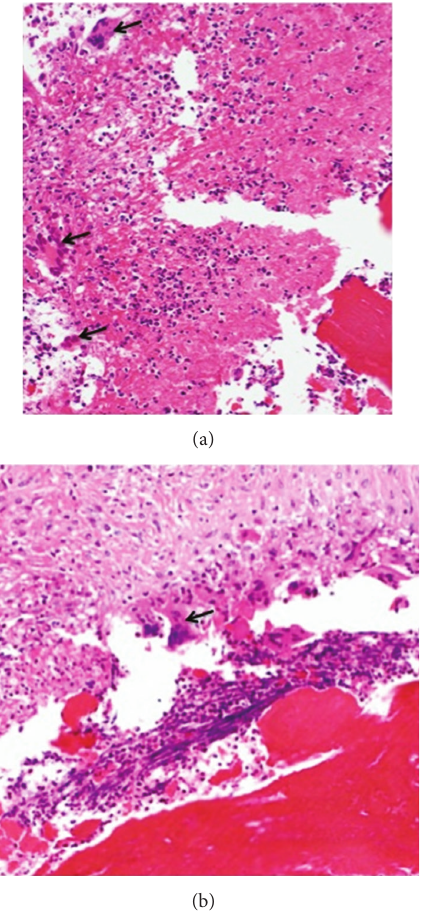
Figure 2: Multinuclear giant cells. In the two regions denoted by rectangles in Figure 1(c), multinuclear giant cells are observed as shown by arrows ((a) and